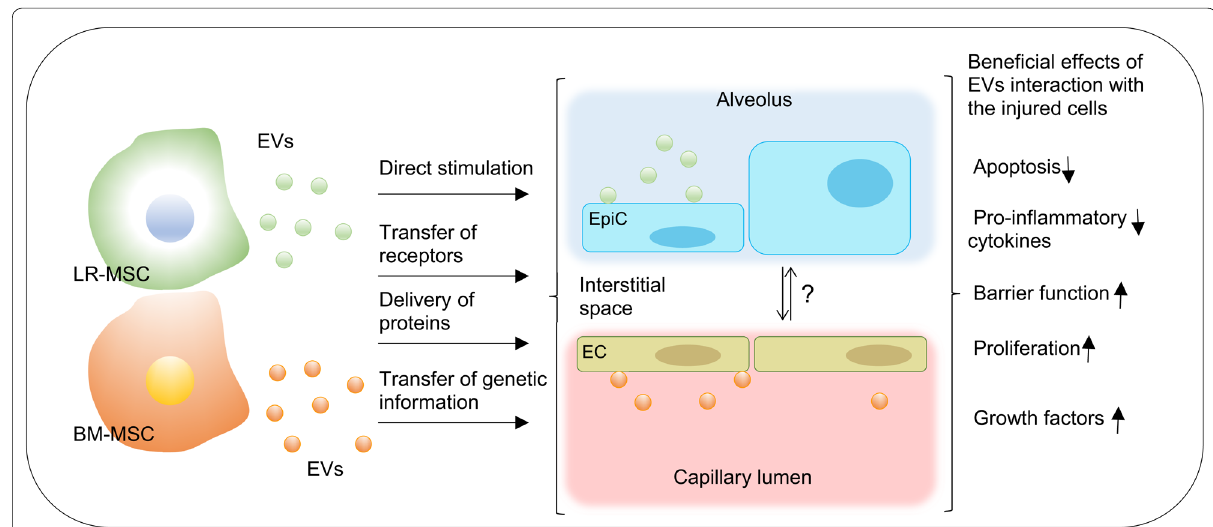
Fig. 1 Effects of MSC-derived EVs in ARDS. After an injury, MSCs are mobilized from their specific niches [bone marrow (BM), adipose tissue, etc.], and transit via the blood to the site of injury. They participate in the tissue repair process, either directly or in a paracrine manner by releasing EVs. Also, under disease conditions, LR-MSCs migrate into the alveolar space and function hand-in-hand with the type II epithelial cells in a paracrine manner by releasing EVs to achieve epithelial repair following injury. The EVs interact/are internalized into the target cells such as endothelial cells, monocytes, macrophages, and neutrophils. The net effects are decreased apoptosis, reduced levels of pro-inflammatory cytokines, improved barrier function and increased proliferation. The cellular crosstalk between the airway epithelium and vascular endothelium and how the behavior of endothelial and epithelial cells is affected by the EVs interaction are not understood. (LR-MSC: lung resident MSC; BM-MSC: bone marrow-derived MSC; EpiC: epithelial cells; EC: endothelial